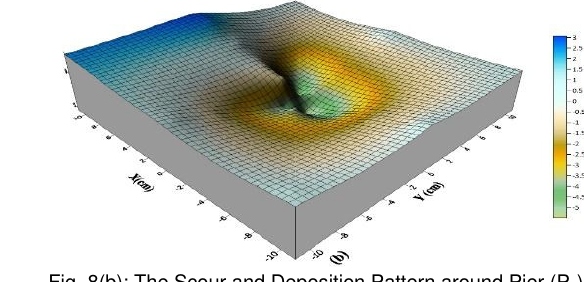
Fig. 8(b): The Scour and Deposition Pattern around Pier (P 2 ) at angle 0 0 and flowrate